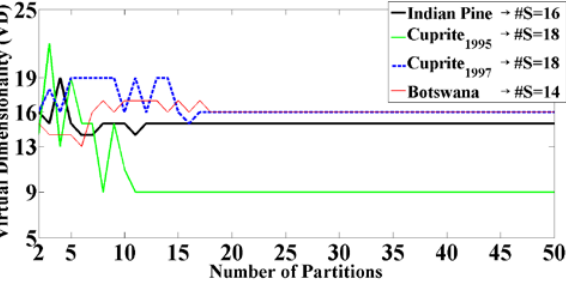
Figure 3. Sensitivity analysis: The impact of the number of partitions on the VDs estimated by the UFSVD method.